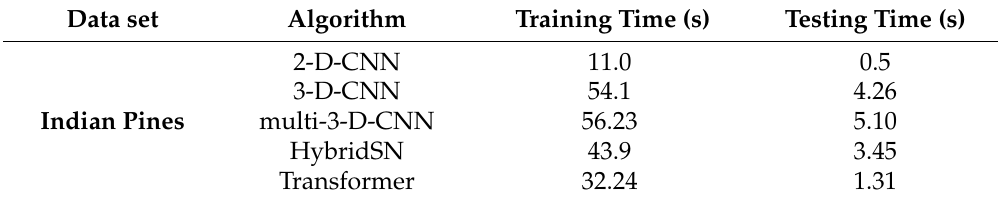
Table 13. Running time of the five methods on the Indian Pines data set. Data set